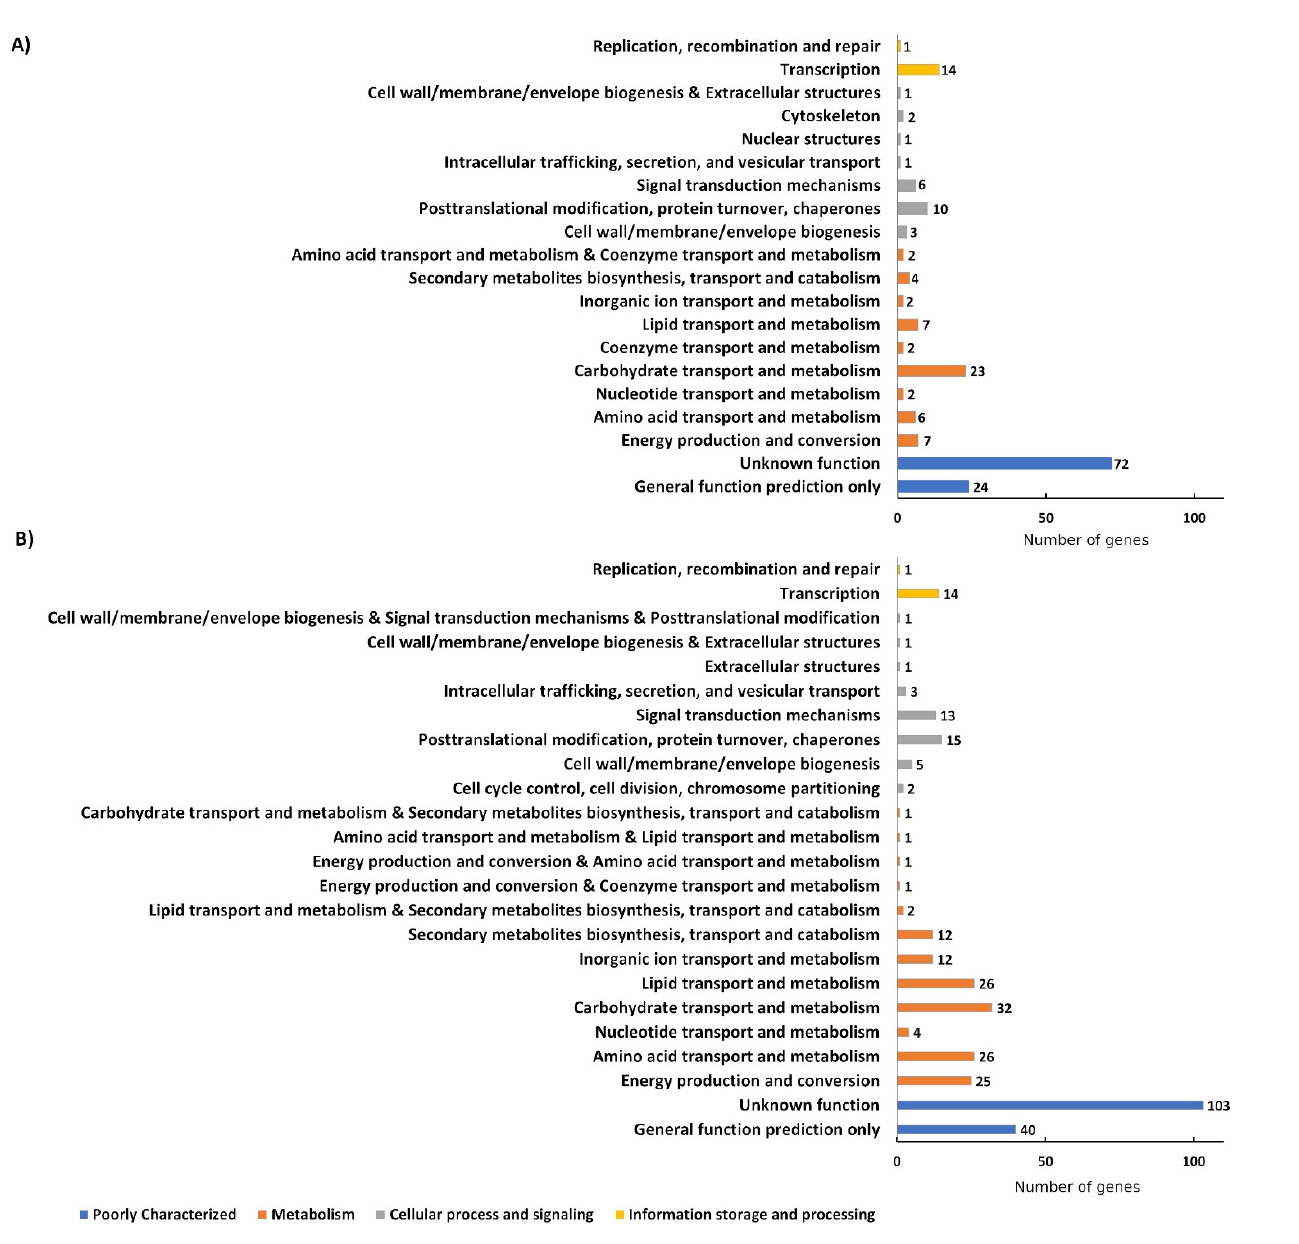
Figure 1. Differentially up- ( A ) and downregulated ( B ) genes of M. lusitanicus grown anaerobically compared to those after aerobic culturing of the fungus and their distribution among the main func- tional categories of the genes.